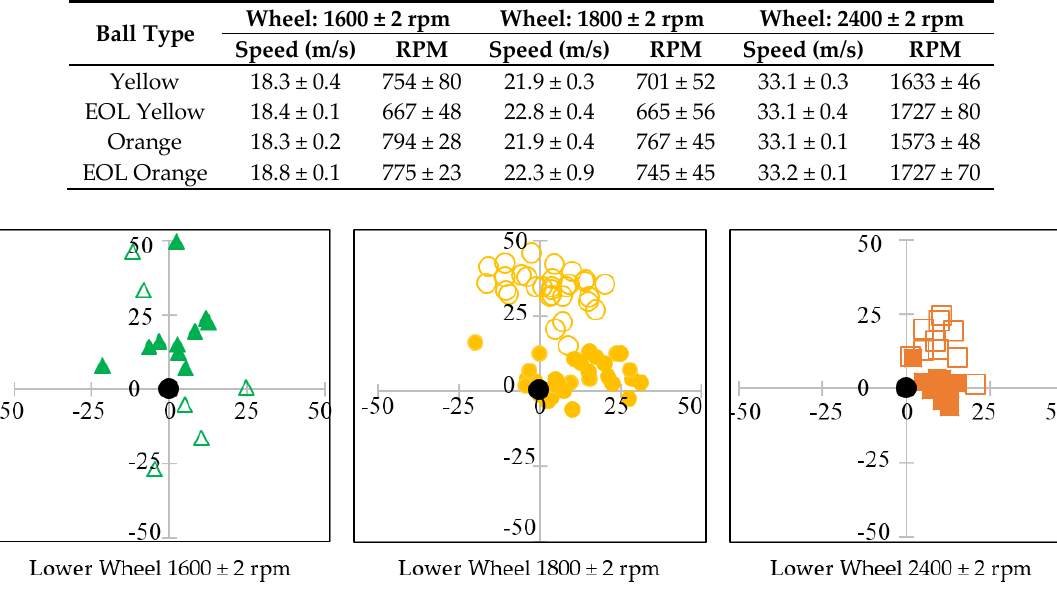
Figure 6. Results of long range studies of yellow baseballs (original-solid markers/EOL-hollow markers) axes units are